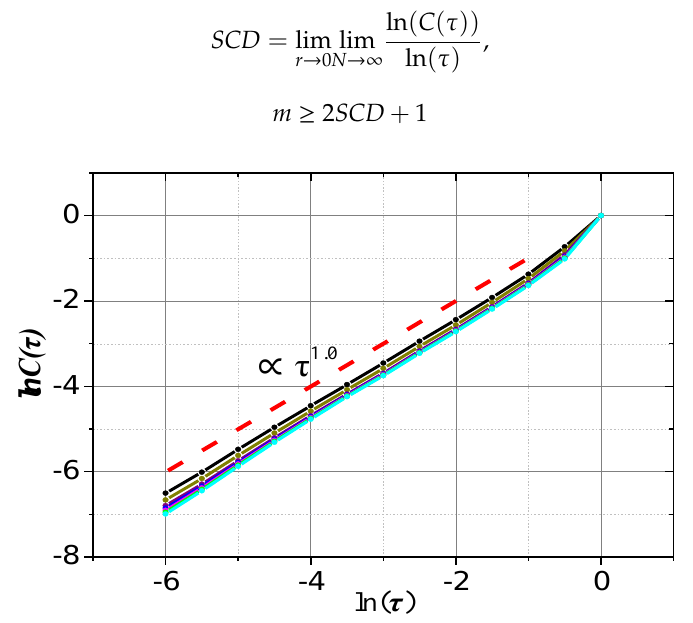
Figure 6. Relation curve between ln C ( τ ) and ln ( τ ) for the circular target.